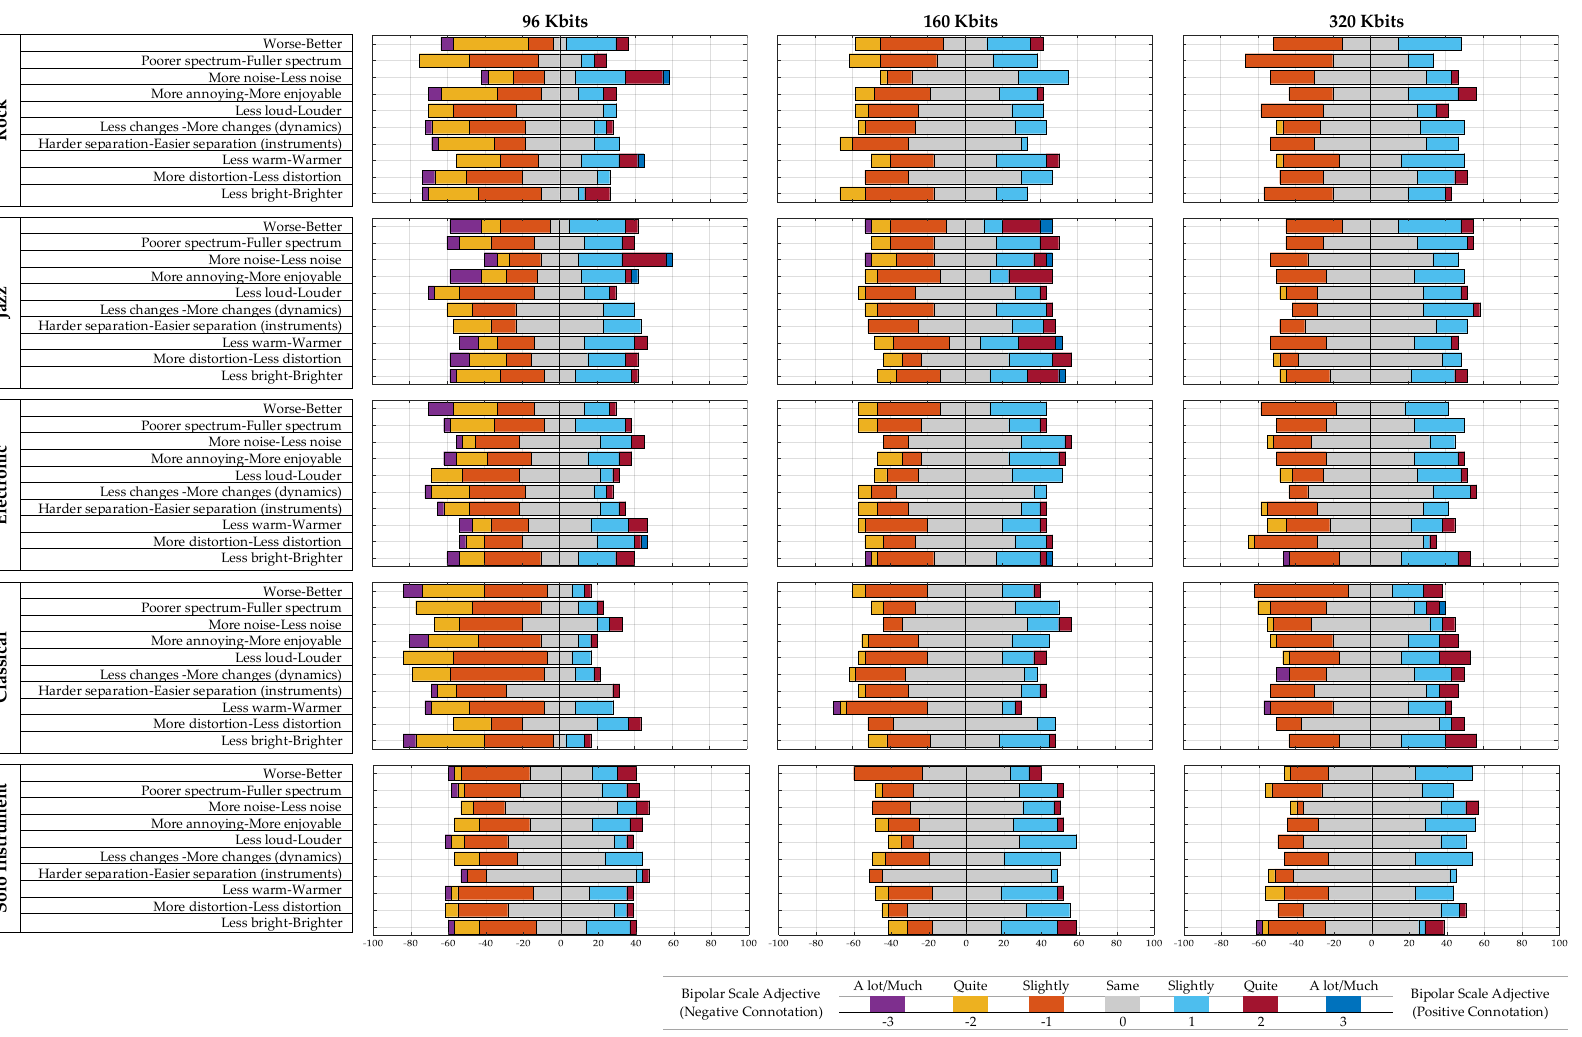
Figure 2. Diverging stacked bar charts for different bitrates and for different